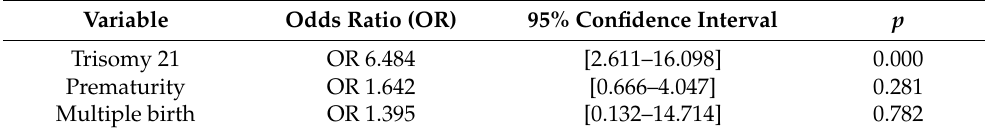
Table 3. Multivariate logistic